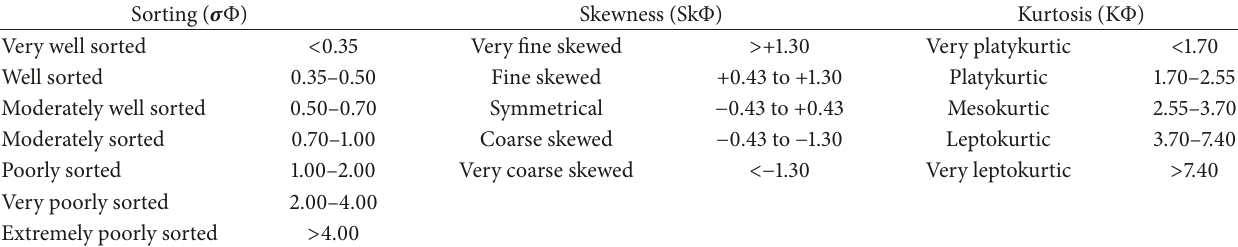
Table 1: Descriptive terminology modified from Krumbein and Pettijohn